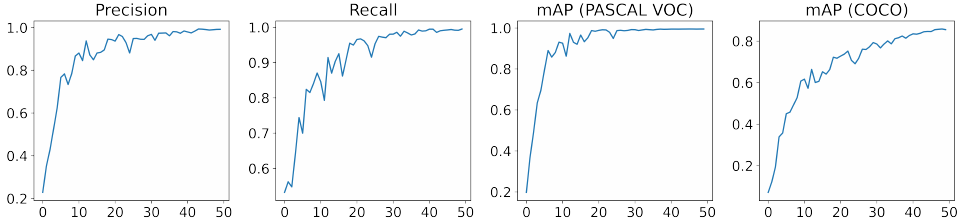
Figure 9. Metrics of YOLOv5m: precision ( first graph ), recall ( second graph ), mAP VOC which corresponds with PASCAL VOC metric ( third graph ) and mAP COCO which corresponds with COCO metric ( fourth graph ).